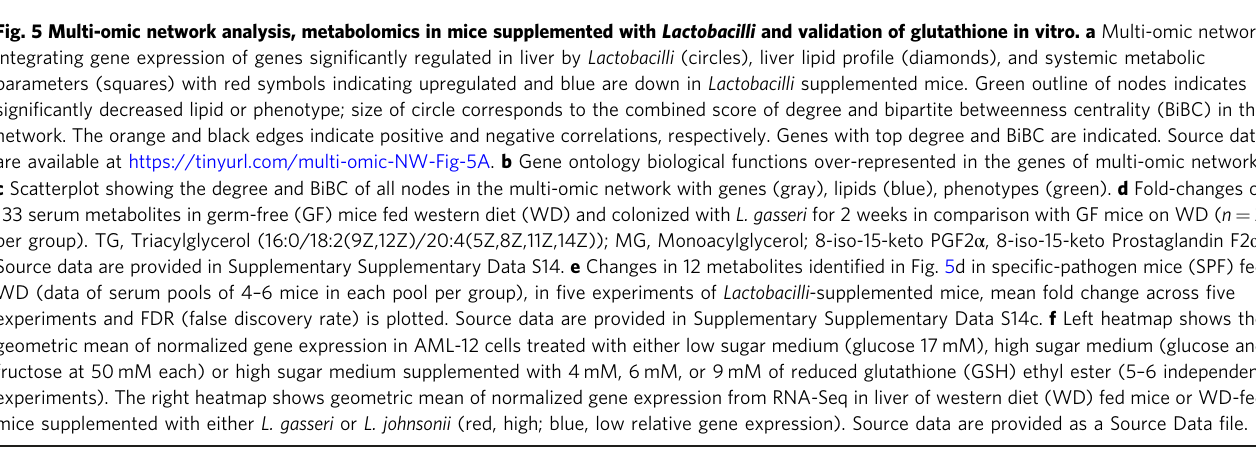
Fig. 5 Multi-omic network analysis, metabolomics in mice supplemented with Lactobacilli and validation of glutathione in vitro. a Multi-omic network integrating gene expression of genes signi fi cantly regulated in liver by Lactobacilli (circles), liver lipid pro fi le (diamonds), and systemic metabolic parameters (squares) with red symbols indicating upregulated and blue are down in Lactobacilli supplemented mice. Green outline of nodes indicates signi fi cantly decreased lipid or phenotype; size of circle corresponds to the combined score of degree and bipartite betweenness centrality (BiBC) in the network. The orange and black edges indicate positive and negative correlations, respectively. Genes with top degree and BiBC are indicated. Source data are available at https://tinyurl.com/multi-omic-NW-Fig-5A. b Gene ontology biological functions over-represented in the genes of multi-omic network. c Scatterplot showing the degree and BiBC of all nodes in the multi-omic network with genes (gray), lipids (blue), phenotypes (green). d Fold-changes of 133 serum metabolites in germ-free (GF) mice fed western diet (WD) and colonized with L. gasseri for 2 weeks in comparison with GF mice on WD ( n = 2 per group). TG, Triacylglycerol (16:0/18:2(9Z,12Z)/20:4(5Z,8Z,11Z,14Z)); MG, Monoacylglycerol; 8-iso-15-keto PGF2 α , 8-iso-15-keto Prostaglandin F2 α . Source data are provided in Supplementary Supplementary Data S14. e Changes in 12 metabolites identi fi ed in Fig. 5d in speci fi c-pathogen mice (SPF) fed WD (data of serum pools of 4 – 6 mice in each pool per group), in fi ve experiments of Lactobacilli -supplemented mice, mean fold change across fi ve experiments and FDR (false discovery rate) is plotted. Source data are provided in Supplementary Supplementary Data S14c. f Left heatmap shows the geometric mean of normalized gene expression in AML-12 cells treated with either low sugar medium (glucose 17 mM), high sugar medium (glucose and fructose at 50 mM each) or high sugar medium supplemented with 4 mM, 6 mM, or 9 mM of reduced glutathione (GSH) ethyl ester (5 – 6 independent experiments). The right heatmap shows geometric mean of normalized gene expression from RNA-Seq in liver of western diet (WD) fed mice or WD-fed mice supplemented with either L. gasseri or L. johnsonii (red, high; blue, low relative gene expression). Source data are provided as a Source Data fi